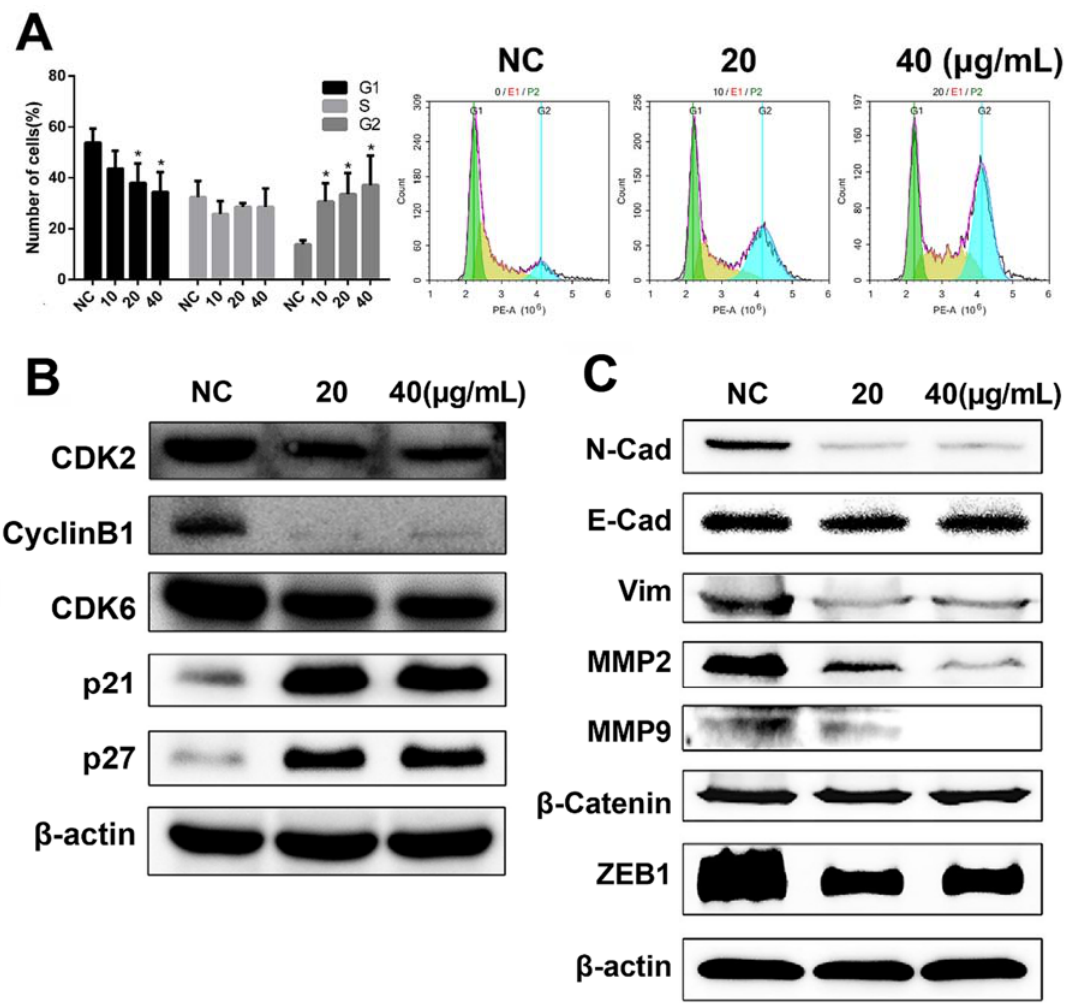
Figure 3. ( A ). A375 cells were incubated with various concentrations (0, 20 or 40 μ g/mL) of DHP1808 for 24 h; the percentages on di ff erent phases of the cell cycle, G1: green, G2: blue, S: yellow. ( B ) A375 cells were incubated with various concentrations (0, 20 or 40 µ g / mL). The expression levels of cell cycle related proteins were determined by western blot analysis. ( C ) A375 cells were incubated with various concentrations (0, 20, or 40 µ g / mL). The levels of EMT-related proteins were determined by western blot analysis. Data represent means ± SD at least three independent experiments, * p < 0.05 versus the control group.